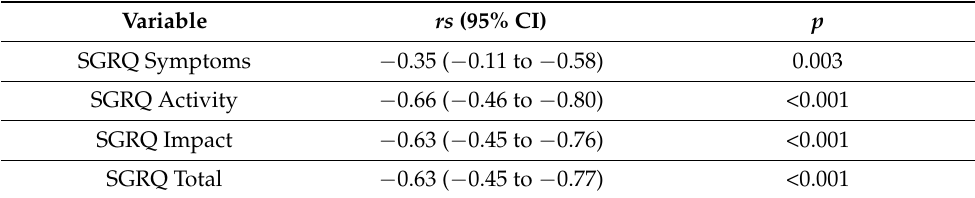
Table 3. Correlation between UEFI and other measures ( N =